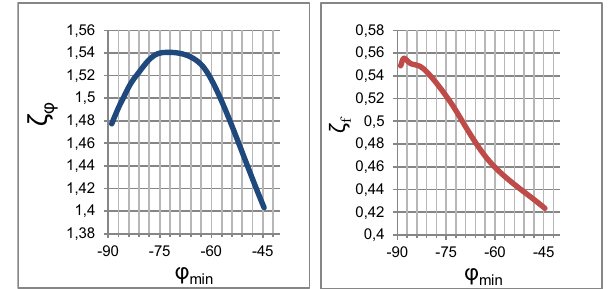
Fig. 3. Calculated values of z ’ and z